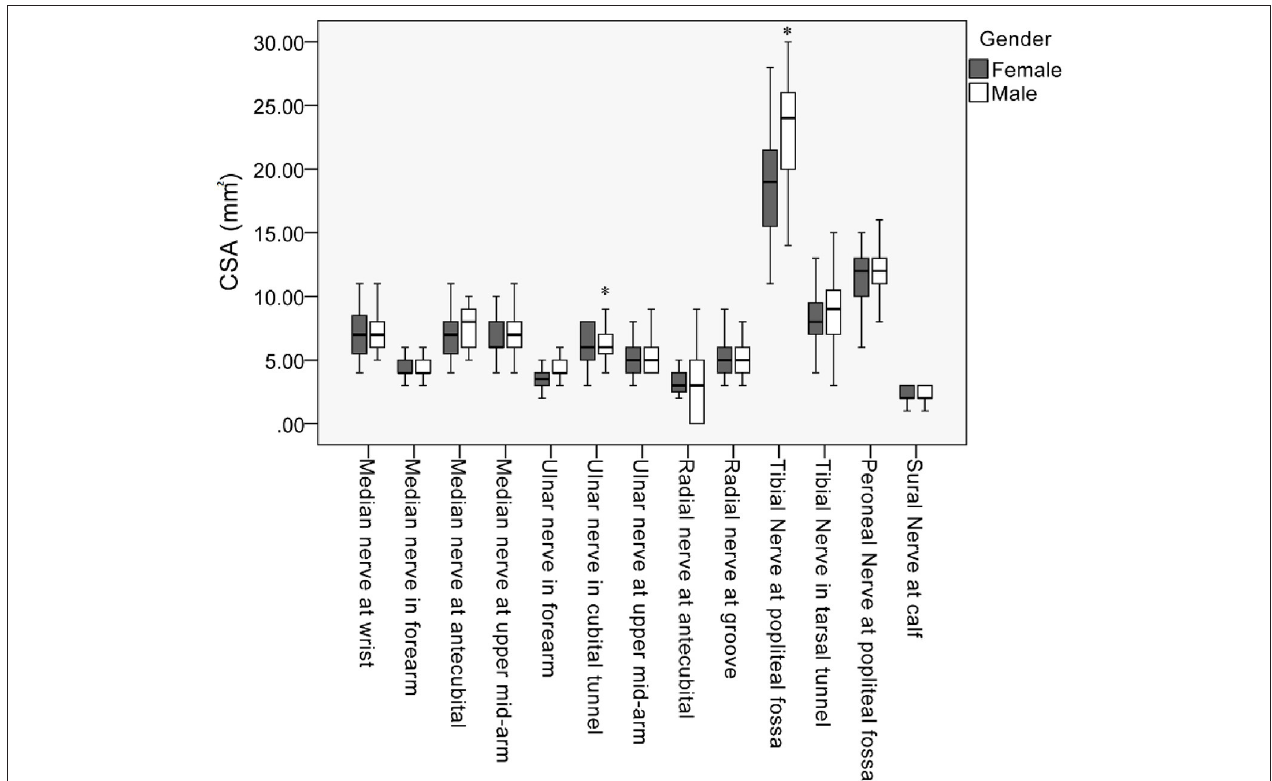
FIGURE 3 | Box plot of cross-sectional area (CSA) values along the median, ulnar, radial, peroneal, and sural nerves. * Statistically significant differences of CSA between male and female in the mean ulnar nerve in cubital tunnel and tibial nerve at popliteal fossa ( P < 0.05).